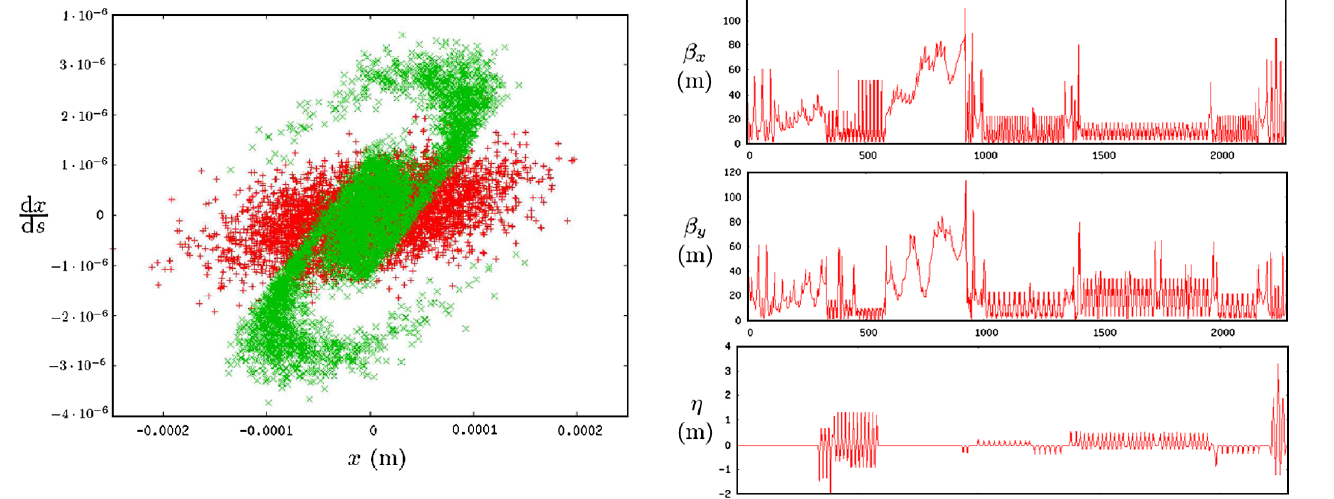
persion.VIDEO 2. Electron beam phase-space distribution after trans- versing the 100 m ion field with (cid:9) (cid:9) (cid:5) 100 m at its center. Dark- red (cid:8) : phase space in a free drift; light-green (cid:4) : phase space for motion through the ion field.